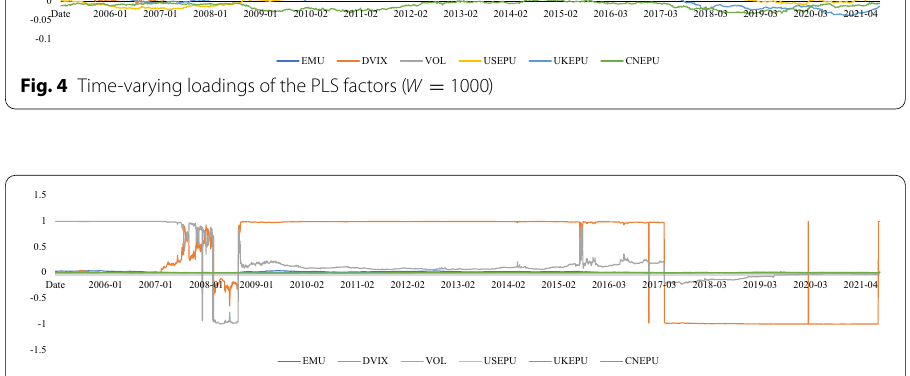
Fig. 5 Time-varying loadings of the Scaled-PCA factors ( W = 1000